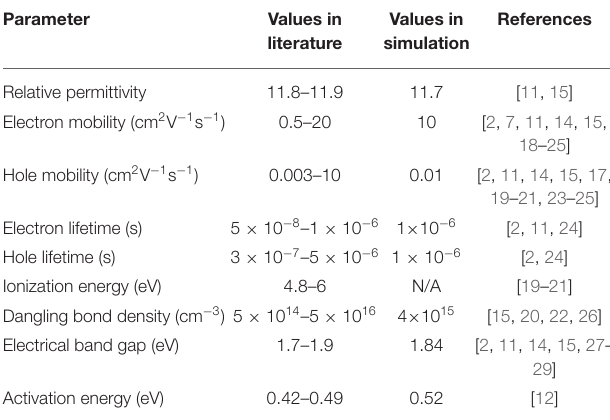
TABLE 1 | Relevant criteria of the a-Si:H parameter file used in this study with comparison to values found in the